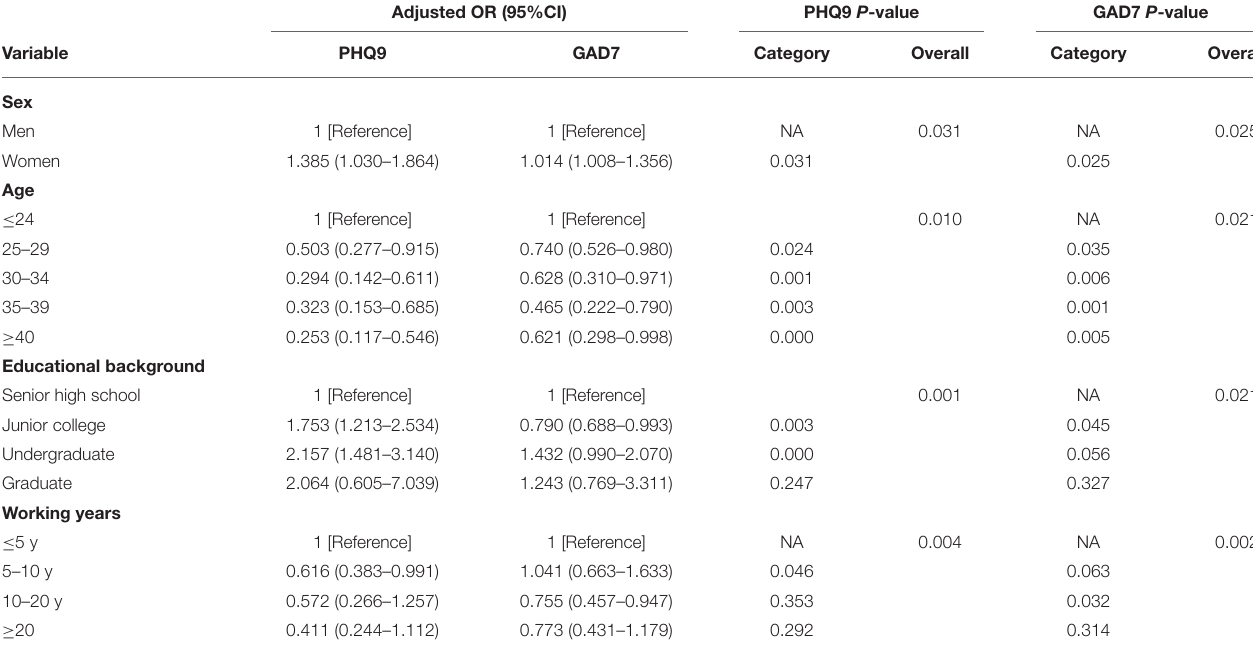
TABLE 4 | Risk factors associated with depression and anxiety measurements in the total cohort and